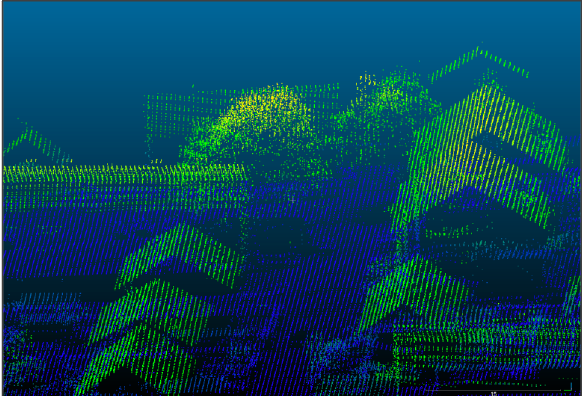
Figure 1. Non-uniform density in trees and roofs in Vaihingen data set (Rottensteiner et al.,